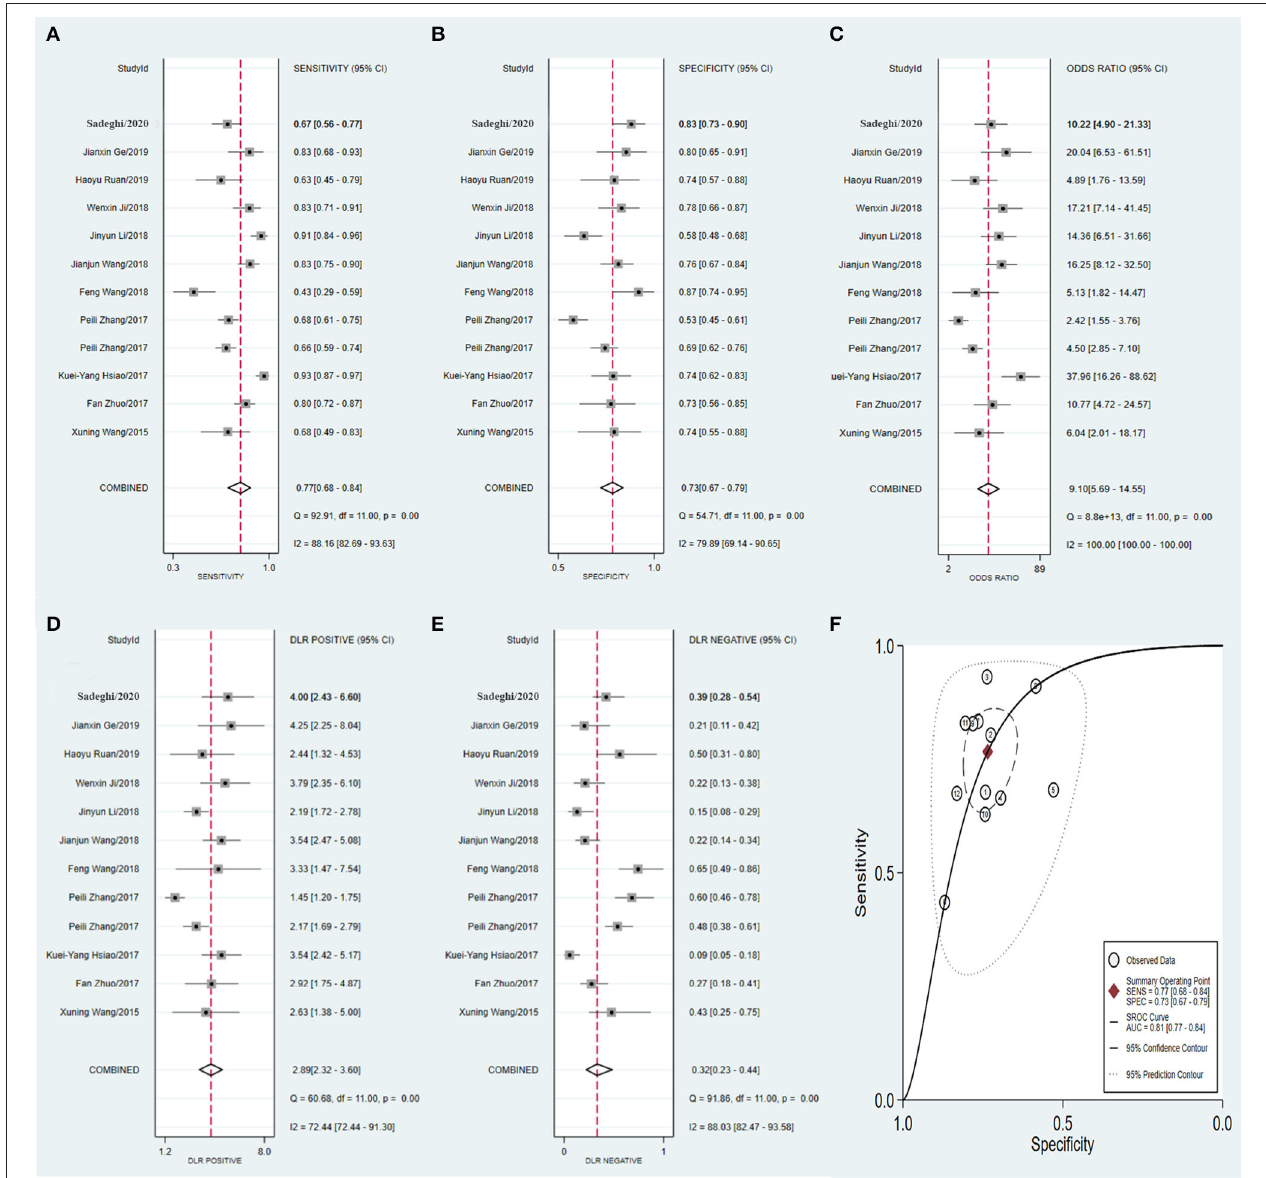
FIGURE 8 | Forest plots of pooled diagnostic power of tissue-derived circRNA as a biomarker for colorectal cancer, (A) Sensitivity, (B) Specificity; (C) DOR; (D) PLR; (E) NLR and (F) AUC. DOR, diagnostics odds ratio; PLR, positive likelihood ratio; NLR, negative likelihood ratio; AUC, the area under receiver operating characteristics